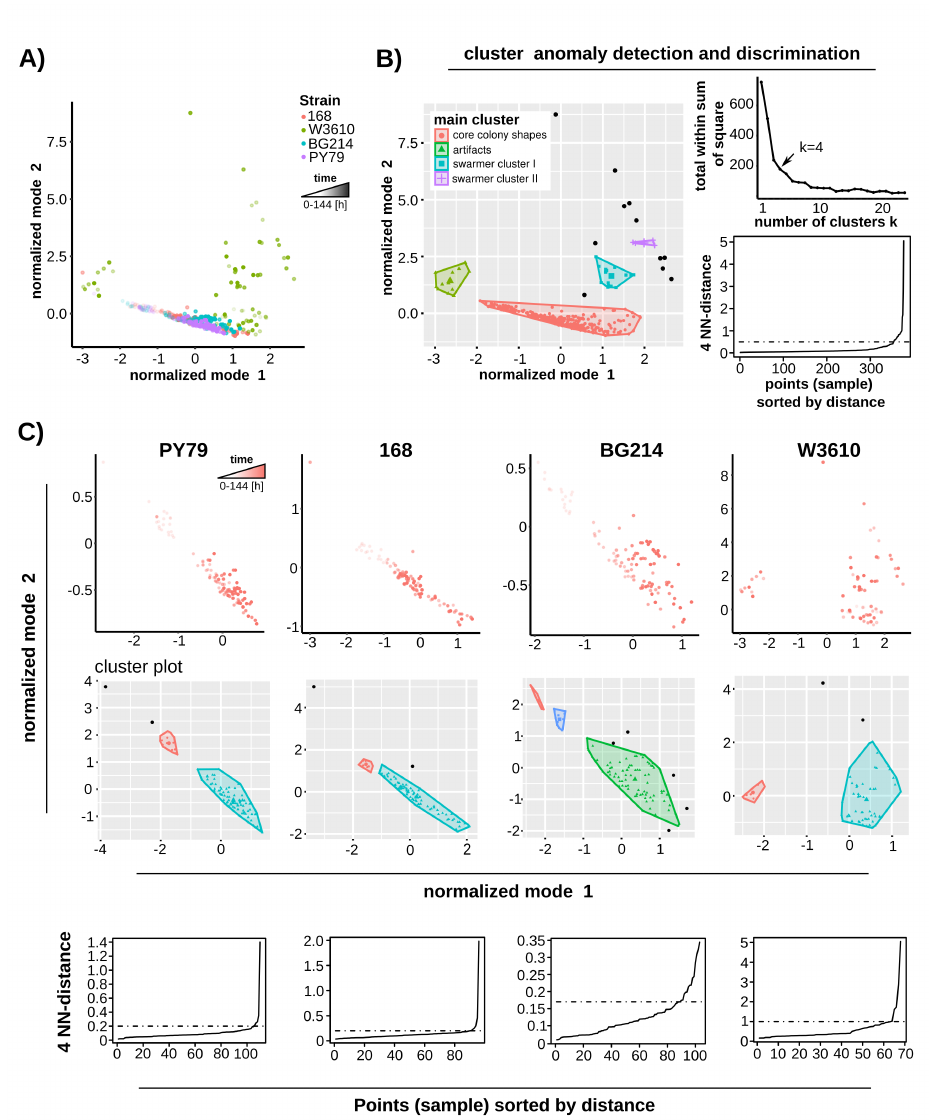
Figure 7. PCA-DBSCAN analysis of B. subtilis . ( A ) Principal components of PY79 (purple), 168 (red), BG214 (blue) and W3610 (olive-green) colony contours are plotted in a scatter plot. Time of colony growth is indicated by spot transparency. ( B ) Cluster anomaly detection and discrimination of principal components. DBSCAN identified three clusters, the core colony shapes (red), the arbitrary- shaped swarmer colonies (blue and purple) and artifacts from contour detection (green). The epsilon value was adjusted according to the distances of the 4 nearest neighbors as illustrated on the right. ( C ) Separate clustering of single strains. (cid:101) -values were adjusted manually according to the 4 nearest- neighbor distances shown below. Identified clusters are depicted for strains PY79, BG214, W3610 and 168. Figure created using Inkscape 0.92.3, available at: https://www.inkscape.org (accessed on 15 September 2022) and ggplot2 [21] available at: https://ggplot2.tidyverse.org (accessed on 15 September